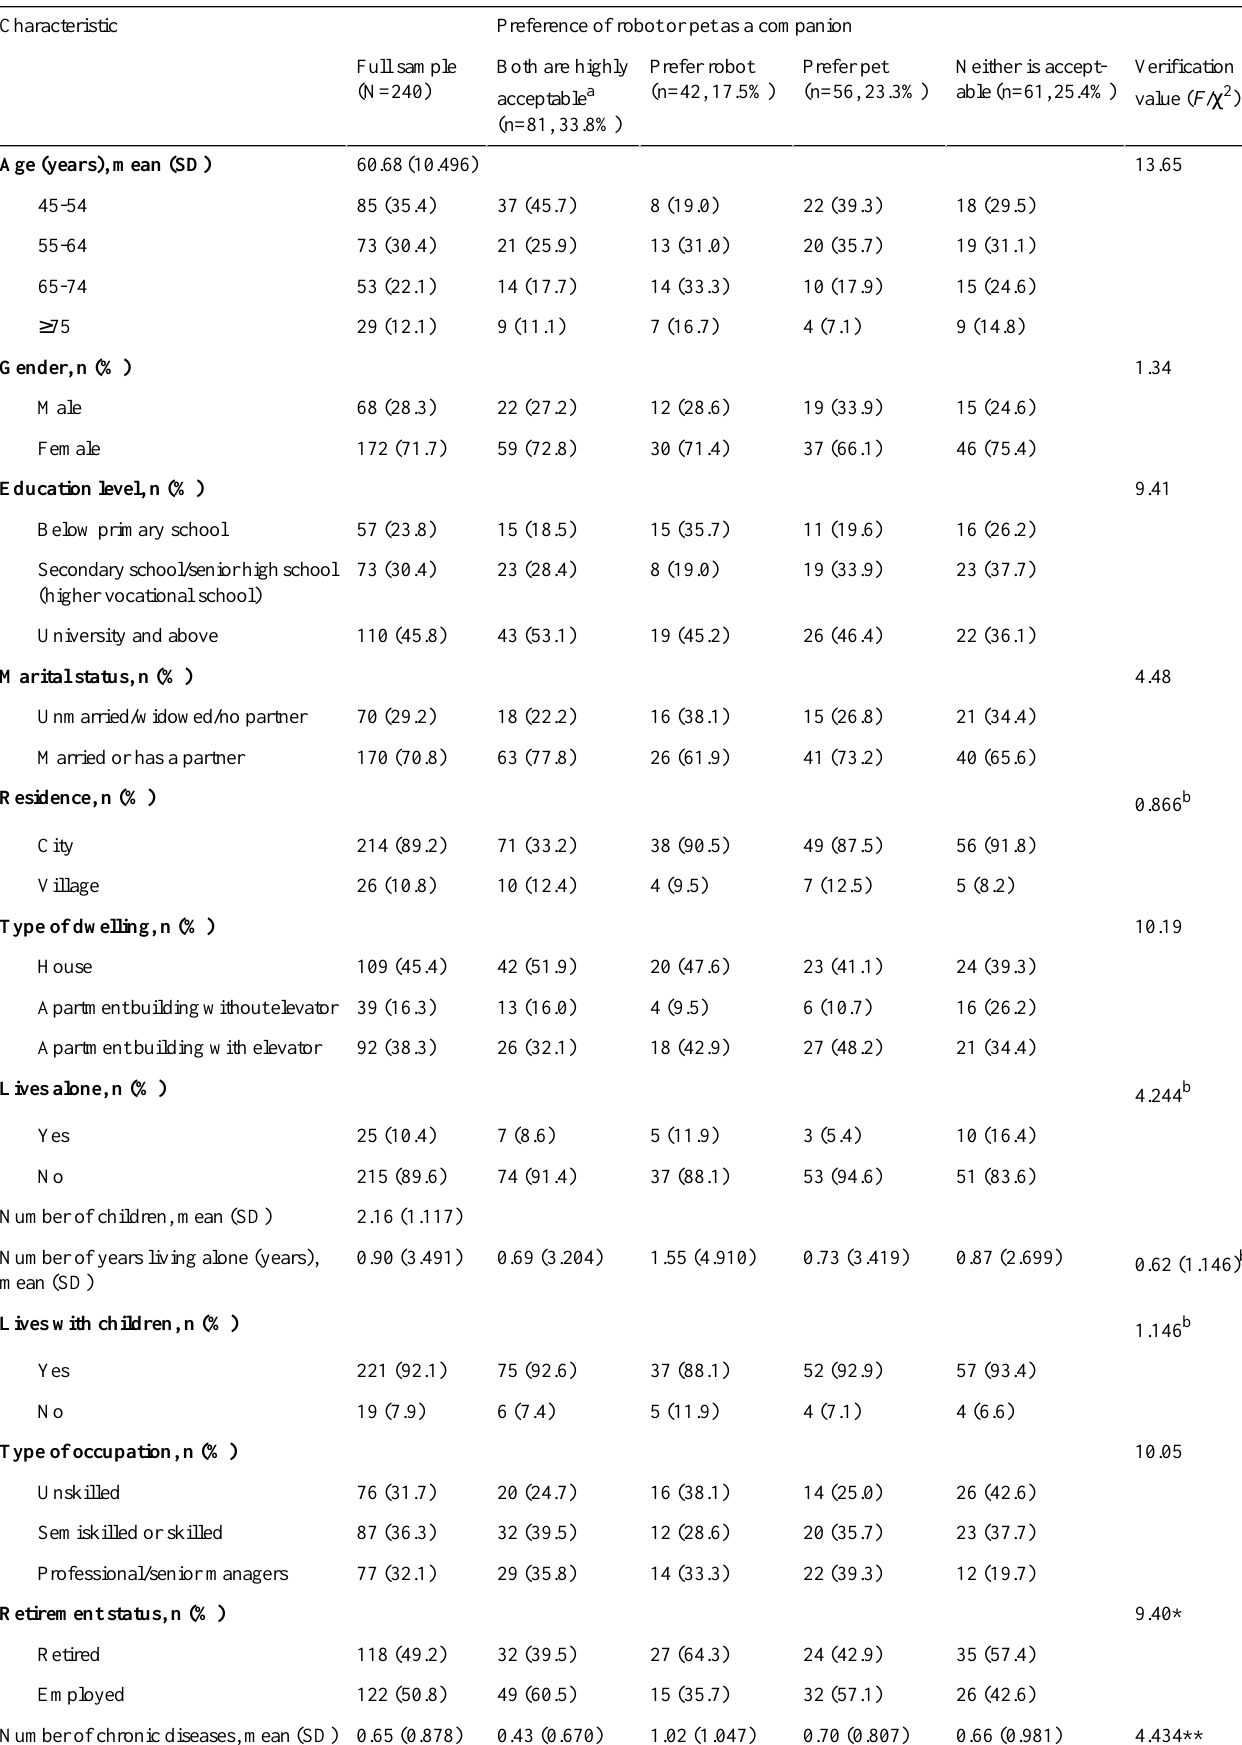
Table 1. Basic sociodemographic data of participants.